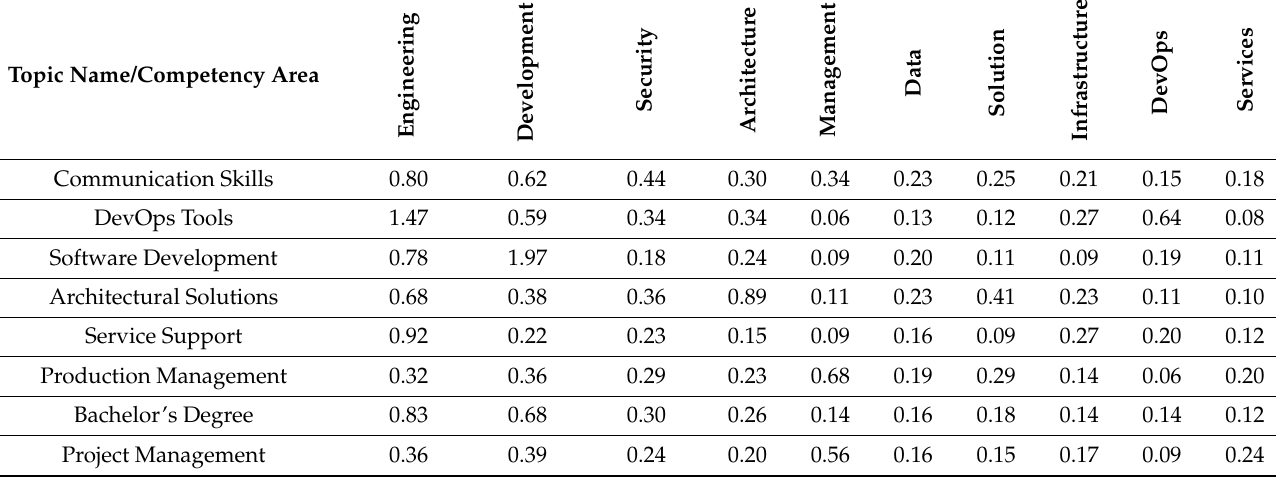
Table 3. Percentages of skills in the top 10